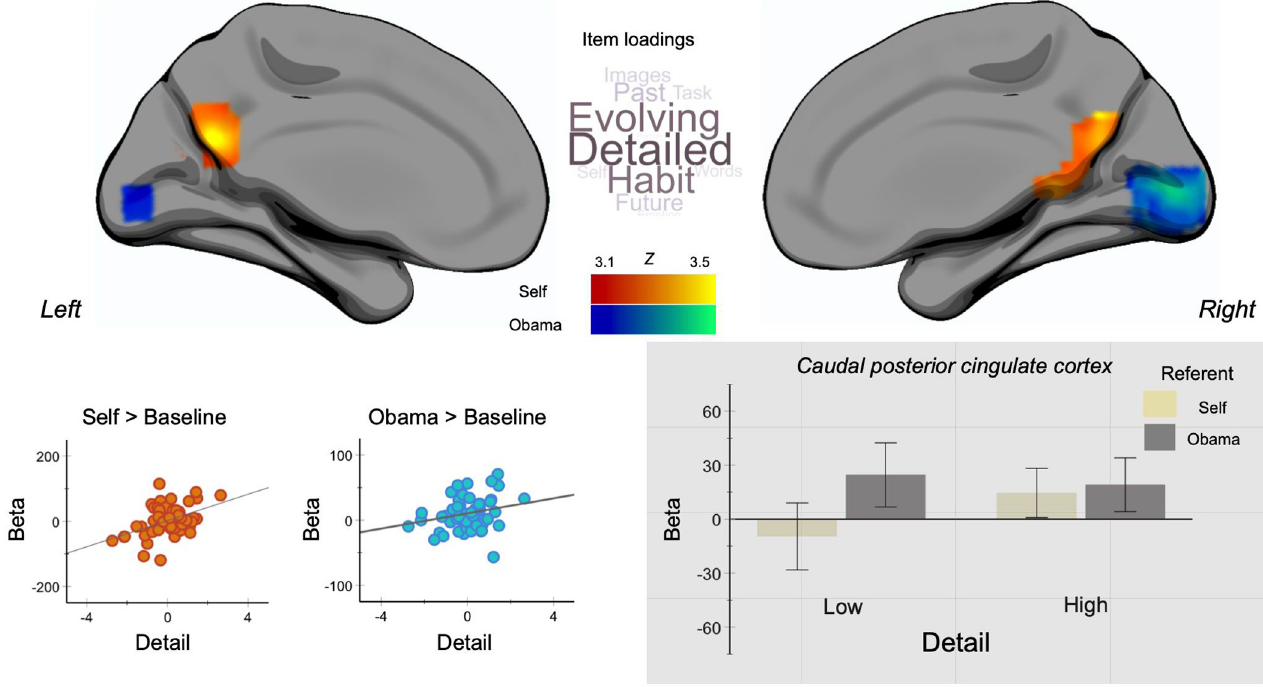
Fig 3. The relationship between patterns of ongoing thought in the laboratory and neural activity during trait adjective judgements. Warm colours describe regions whose neural activity during self-trait judgements was correlated with levels of detail in ongoing experience in the lab. Cool colours describe regions whose neural activity during other-trait judgements was correlated with the level of detail in ongoing thought. Spatial maps were thresholded at Z = 3.1 controlling for multiple comparisons p < .05 (FWE). The scatter plots display the association between individual’s detail component score and neural activity extracted from posterior cingulate cortex (PCC) (warm colours) and medial occipital cortex (cool colours) respectively. Notably, the PCC cluster also showed a selective increase when making trait judgements regarding Barack Obama relative to the Self (see Figs 2 and S4). The bar graph in the grey inset shows the signal in the caudal PCC cluster in each condition (Self / Other) plotted for individuals whose thoughts in the lab were below (Low) and above (High) the median for the Detail dimension. Thus, individuals who engaged in detailed thought within the laboratory recruited caudal posterior cingulate cortex above baseline when making trait adjective judgements based on either Self or Other as the source of the judgement. The error bars indicate the 95% C.I. The word cloud summarises the pattern of loadings that correspond to the detail component. Larger fonts describe a higher loading.